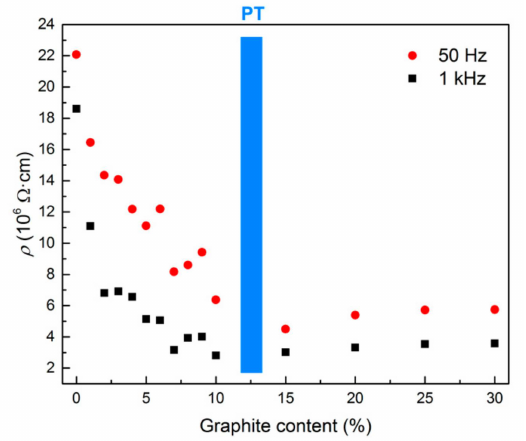
Figure 7. Change in the electrical resistivity of AAS composites with respect to graphite content at 50 Hz and 1 kHz (PT = percolation